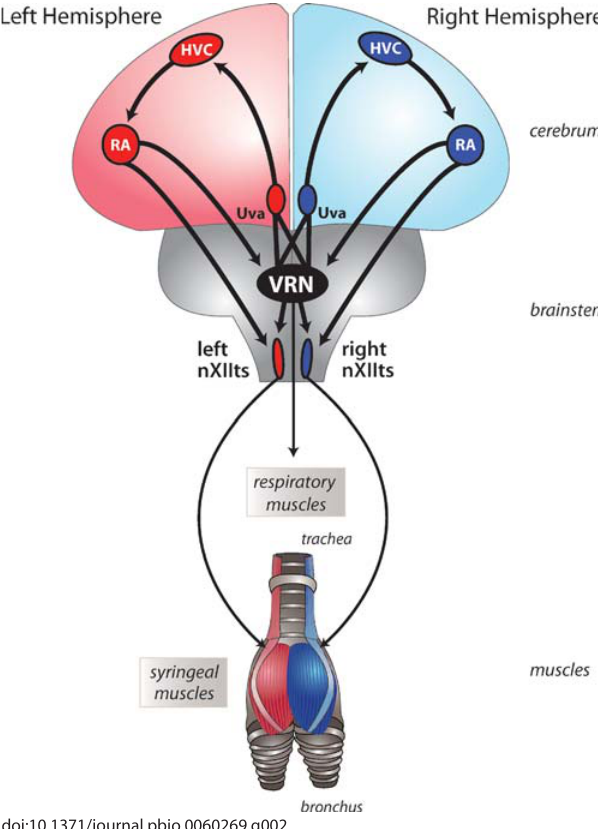
Figure 2. Bilateral Organization of the Song Motor Control System This schematic is a simplified representation of the motor portion of the avian song system emphasizing its bilateral organization. Sound is produced in a bipartite vocal organ known as the syrinx. The syringeal muscles that make up each half of the vocal organ are innervated by motoneurons in the ipsilateral nXIIts. This nucleus receives its own motor commands from HVC and RA in the ipsilateral forebrain. Therefore, motor commands generated in the left hemisphere (highlighted in red) end up activating muscles on the left half of the syrinx, while those on the right side (highlighted in blue) activate syringeal muscles on the right side. Motor commands from each hemisphere are also sent to brainstem nuclei that form part of the bilaterally organized vocal- respiratory network (VRN), which is highly interconnected across the midline. The VRN sends motor commands to the muscles of respiration. This network also sends major projections back to the forebrain nucleus HVC via the intermediary of the thalamic relay nucleus uvaeformis (Uva). These bottom-up projections are thought to synchronize activity in both hemispheres and might play a role in the rapid hemispheric switching described by Wang et